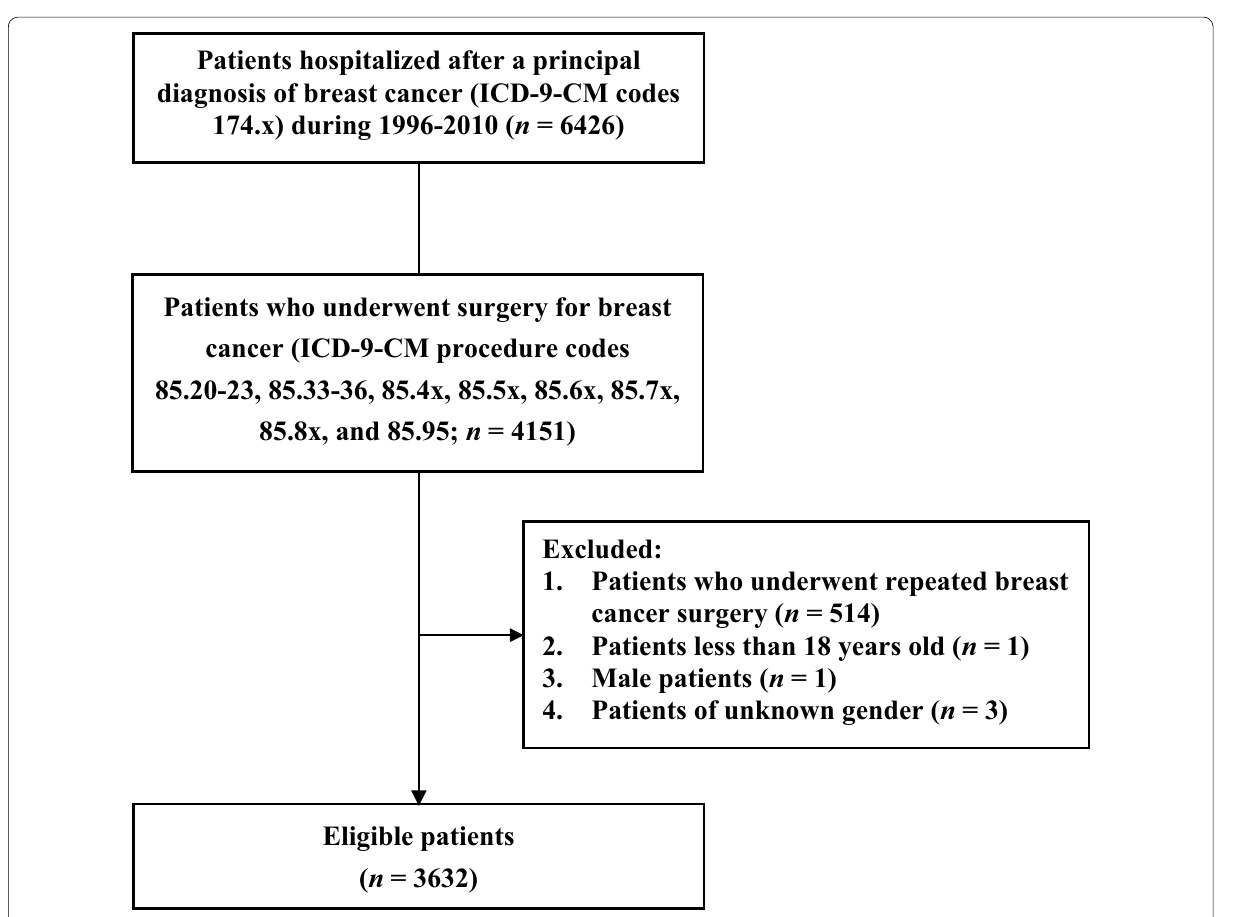
Fig. 1 Flowchart of the study